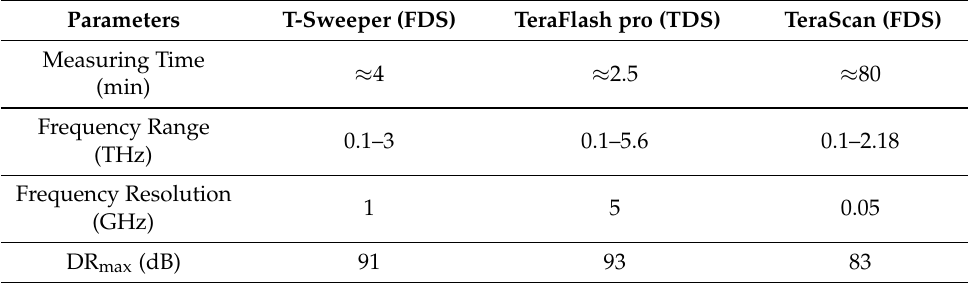
Table 1. Summary of the parameters for the three used devices with the respective settings. Parameters T-Sweeper (FDS) TeraFlash pro (TDS) TeraScan (FDS) Measuring